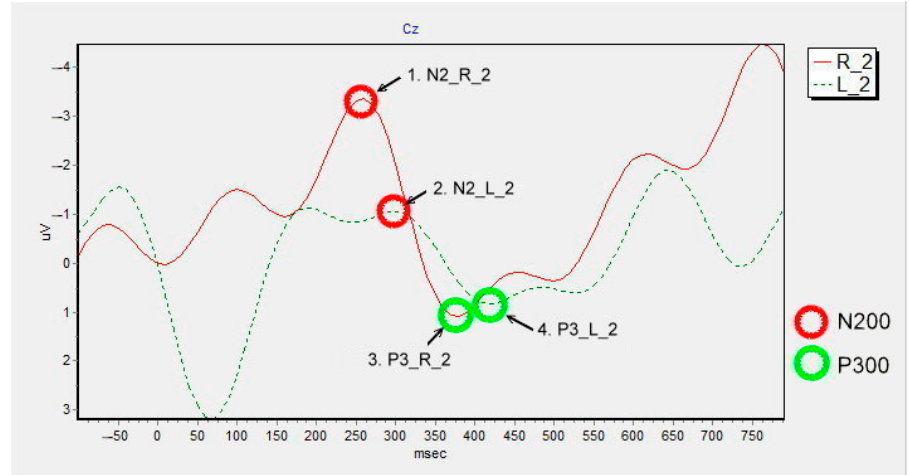
Figure 4. Average waveforms at Cz of the second stage of the 4th test run from participant N04: The red circles mark the locations of N200 (marks 1 and 2), while the green circles mark the locations of P300 (marks 3 and 4).